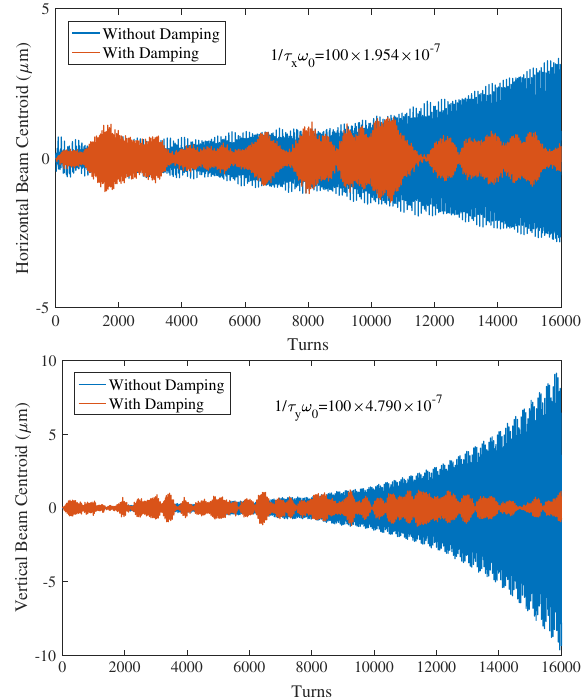
FIG. 19. Motion of beam centroid with and without detuning.